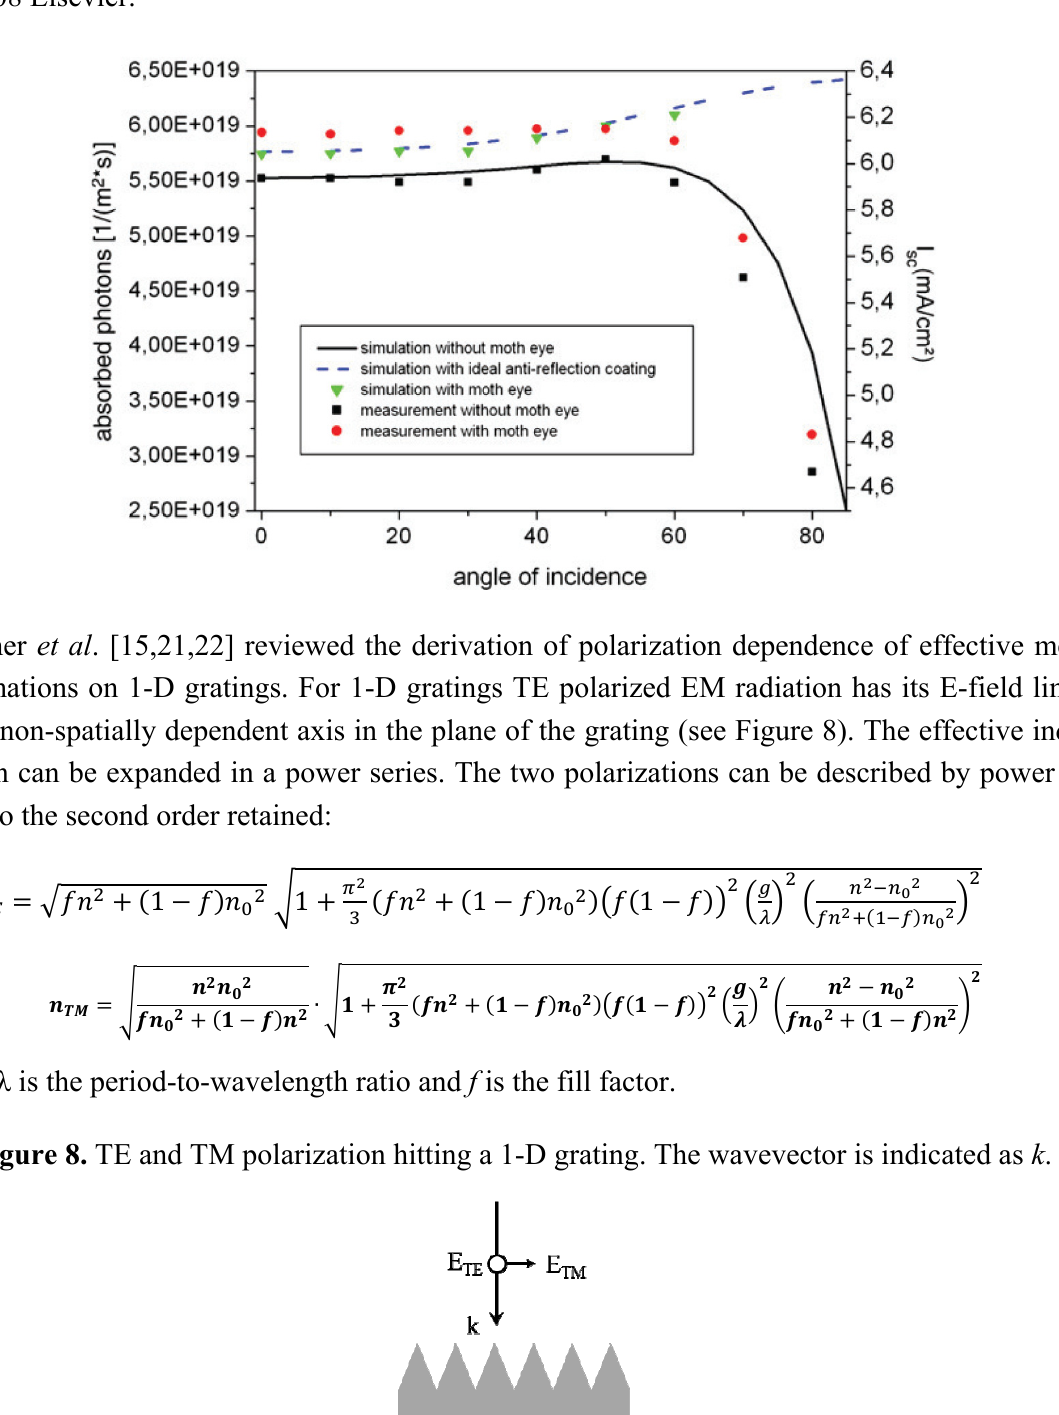
Figure 7. Simulation with effective medium theory (EMT) and measurement results of short circuit current from organic solar cells with no ARC, with a moth eye ARC, and with an idea GRIN structure ARC. Reprinted with permission from reference [20], Copyright 2008 Elsevier.